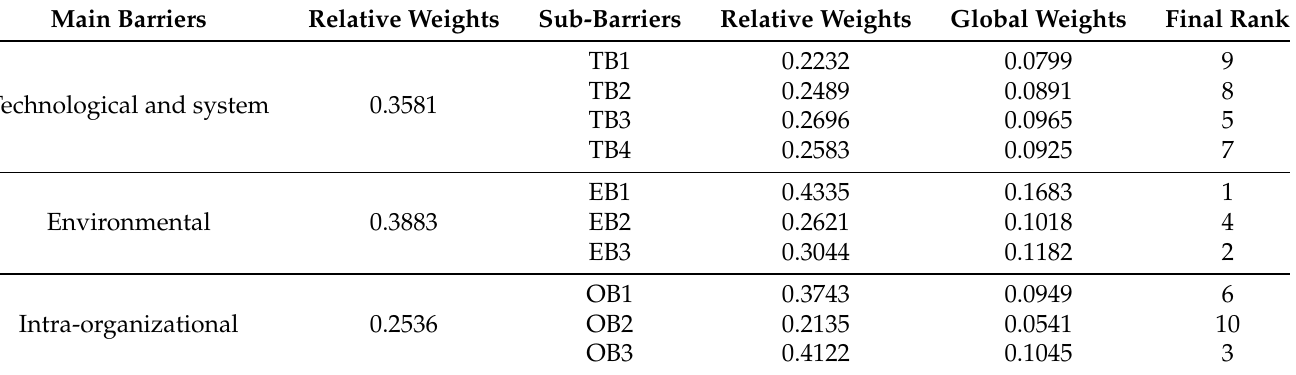
Table 9. Final importance weights of all